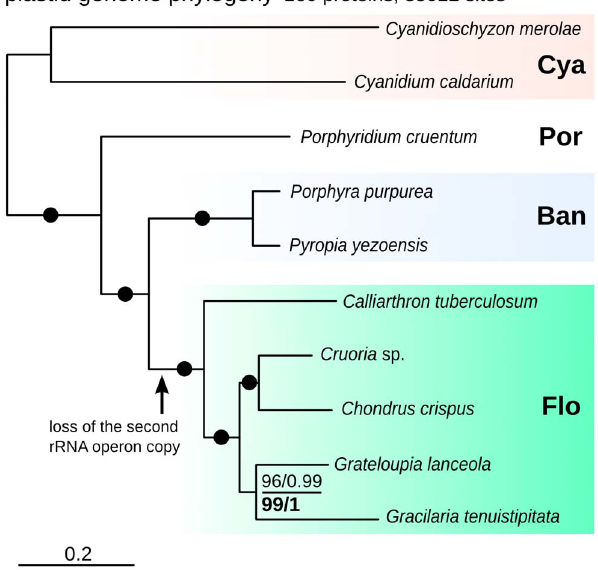
Figure 5. Maximum likelihood phylogeny of 160 concatenated red algal plastid genes. Major lineages are shaded and named to the right (Cya Cyaninidiales; Por Porphyridiales; Ban Bangiales; Flo florideophytes). The phylogeny is fully supported except for the node uniting G. lanceola and G. tenuistipitata , for which RAxML rapid boostrap (left) and PhyML SH-aLRT supports (right) are shown for